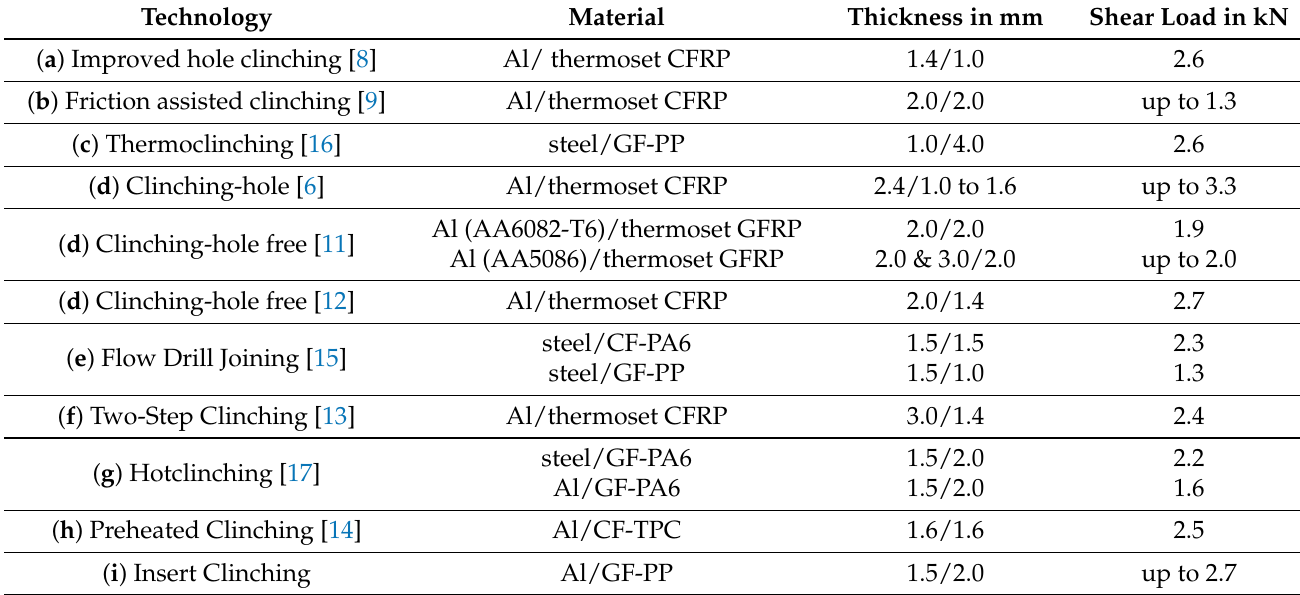
Table 3. Comparison of the maximum shear